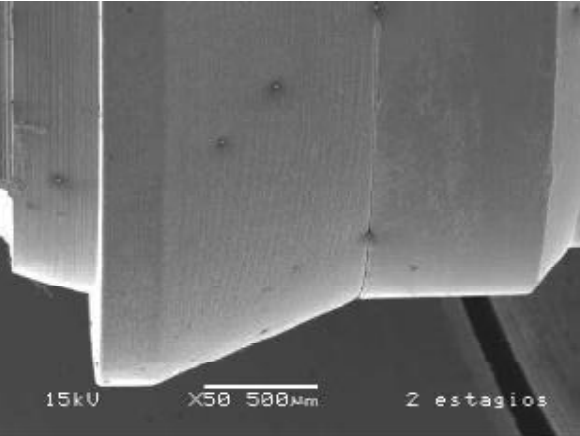
FIGURA 11- Observação da fenda (seta) no sentido transversal no sistema de um estágio (x200)